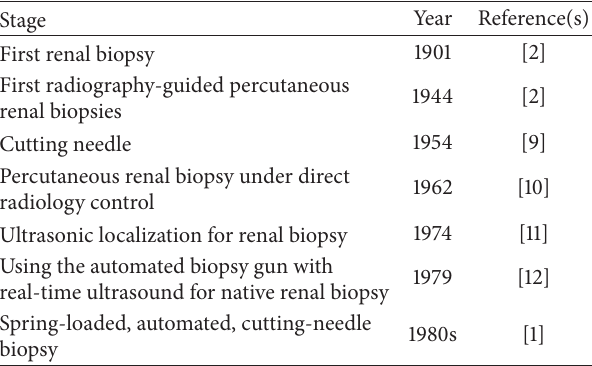
Table 1: The main milestones of the renal biopsy in last century.